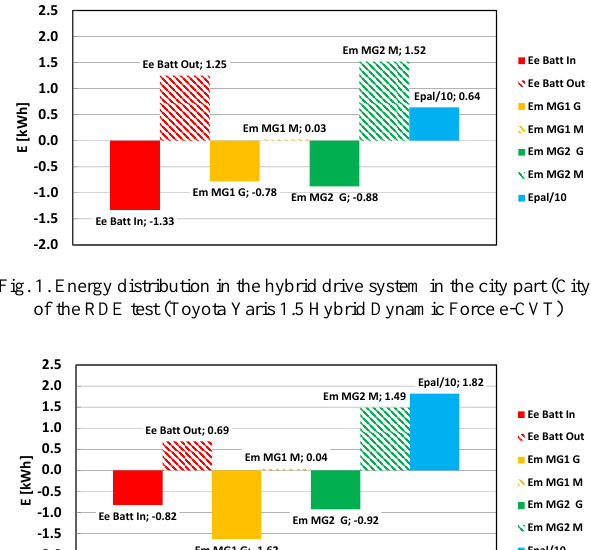
Fig. 4. The course of the braking process in the hybrid drive system